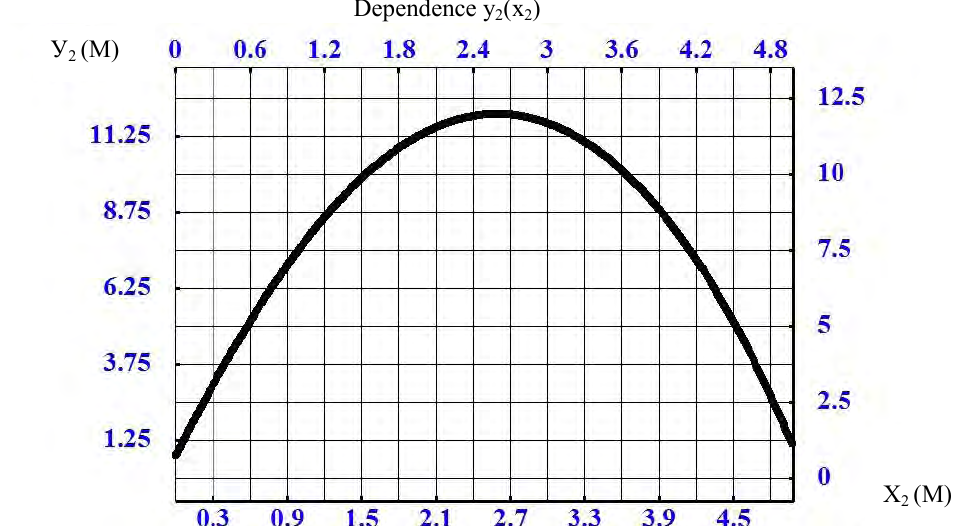
Fig.3. Graph dependence of flight parameters of hoop for time t=3sec.; VС 0 =16.5m/sec; α C0 =83 0 ; h Cо =0.75m.; m= 0.3kg.